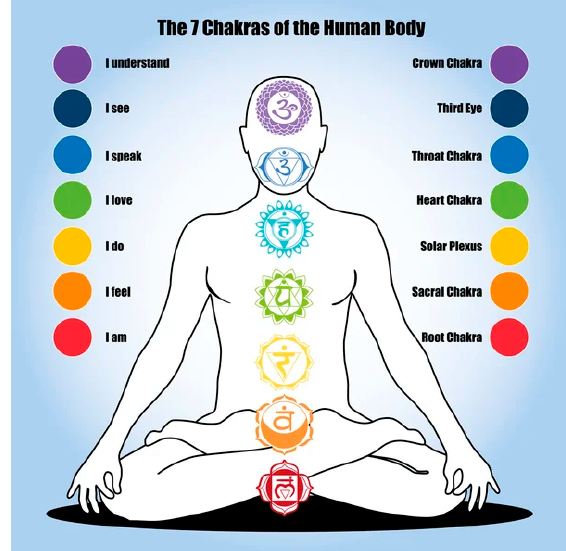
Figure 1. Seven Chakras and Our Health (123RF n.d.).